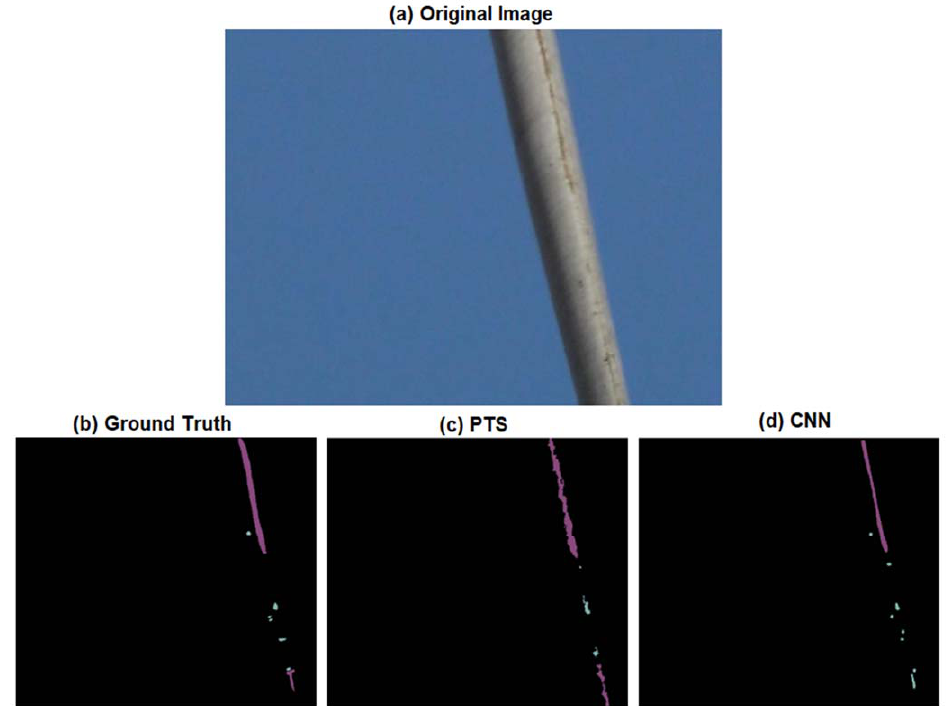
Figure 10. Example ( a ) field image and output of automated ( c ) PTS and ( d ) CNN LEE quantification and classification for shallow (green) and deep (magenta) LEE compared to ( b ) ground-truth LEE quanti fi cation and classi fi cation.